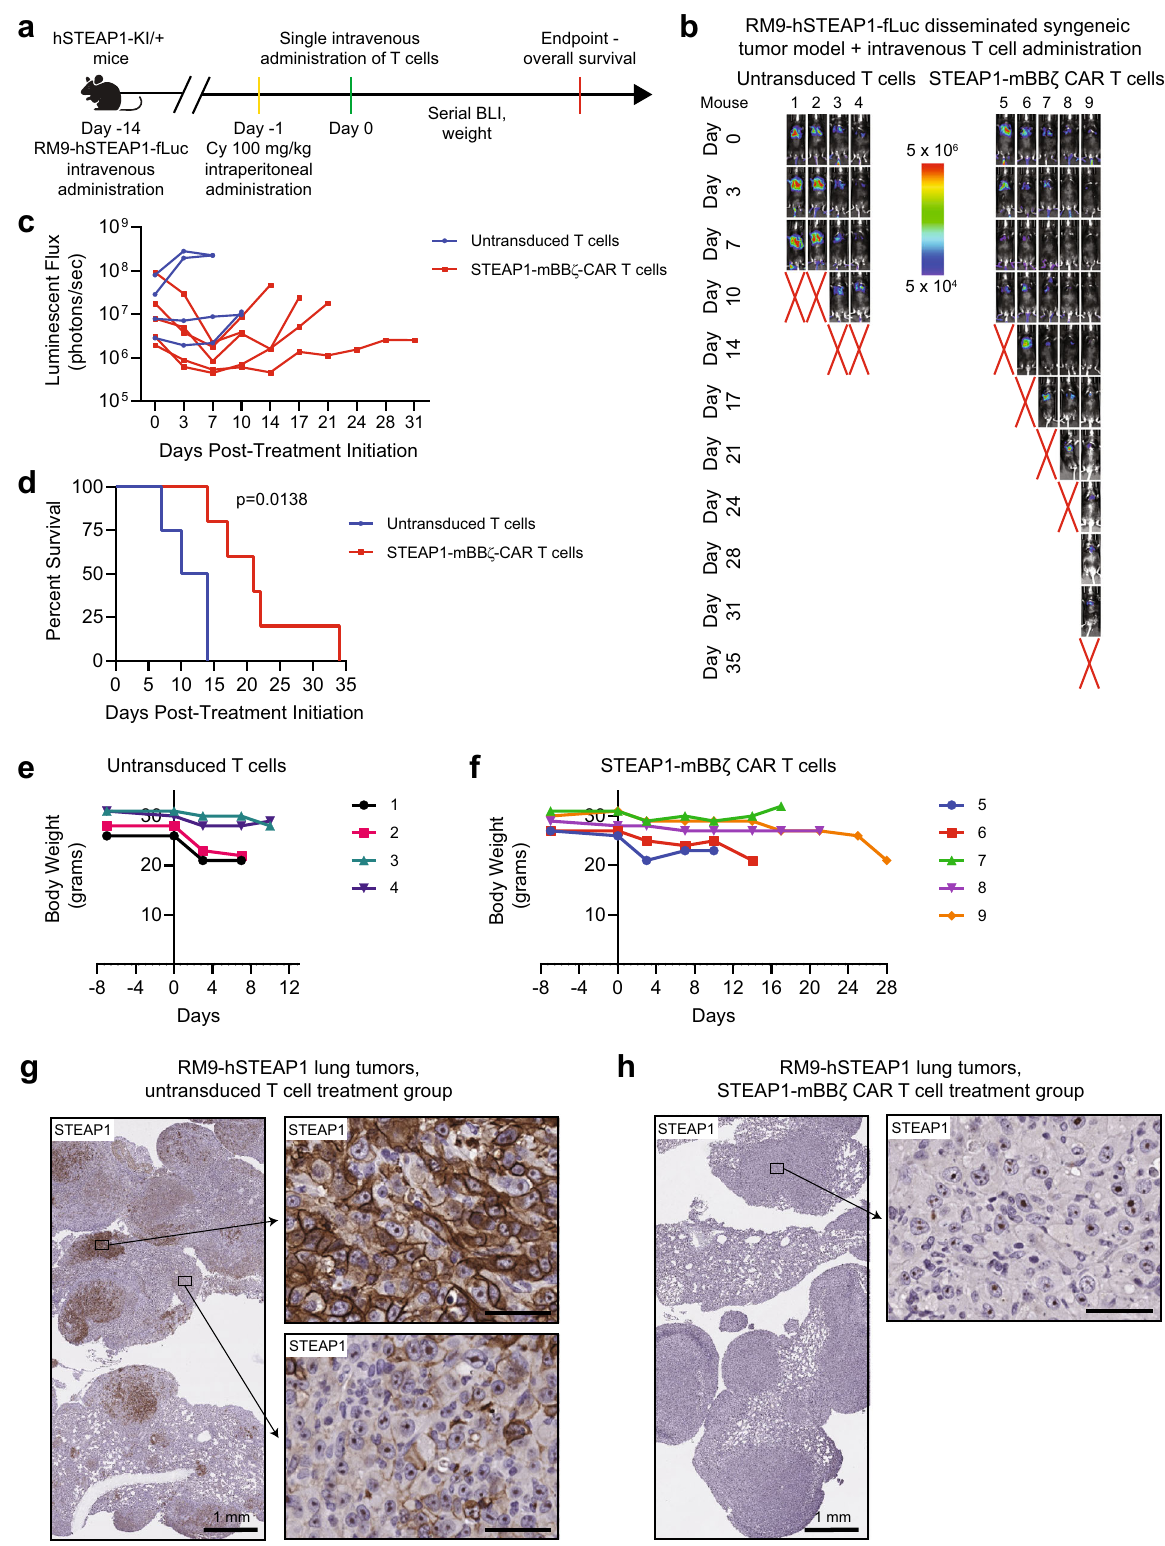
Collagen binding domain-IL-12 fusion cytokine elicits antitumor responses through enhanced T cell receptor signaling and antigen